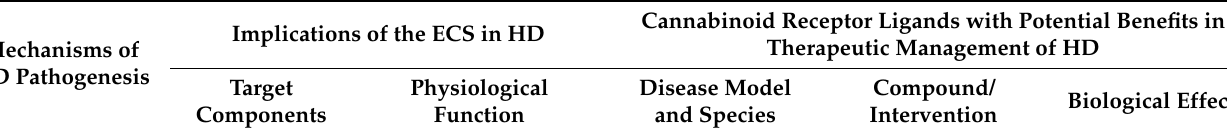
Table 3. Involvement of ECS in various pathological aspects of